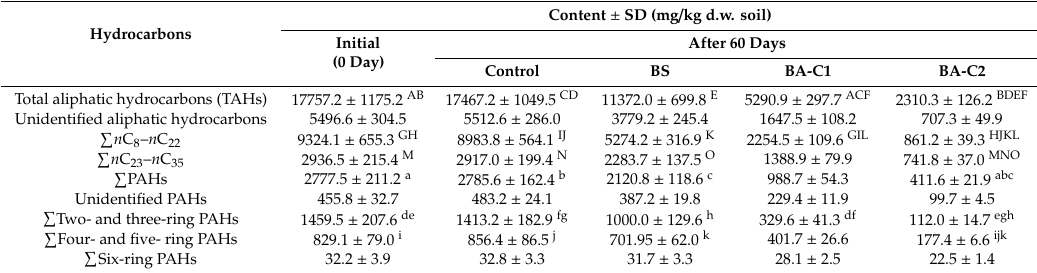
Table 2. Initial and residual contents of total aliphatic hydrocarbons (TAHs), unidentified hydrocarbons, (cid:80) (cid:80) n C 8 –nC 22 and n C 23 – n C 35 ) and polycyclic aromatic hydrocarbons ( alkanes ( PAHs, and distinguished PAH groups. The data are presented as the mean values ± SD ( n = 4). Hydrocarbons